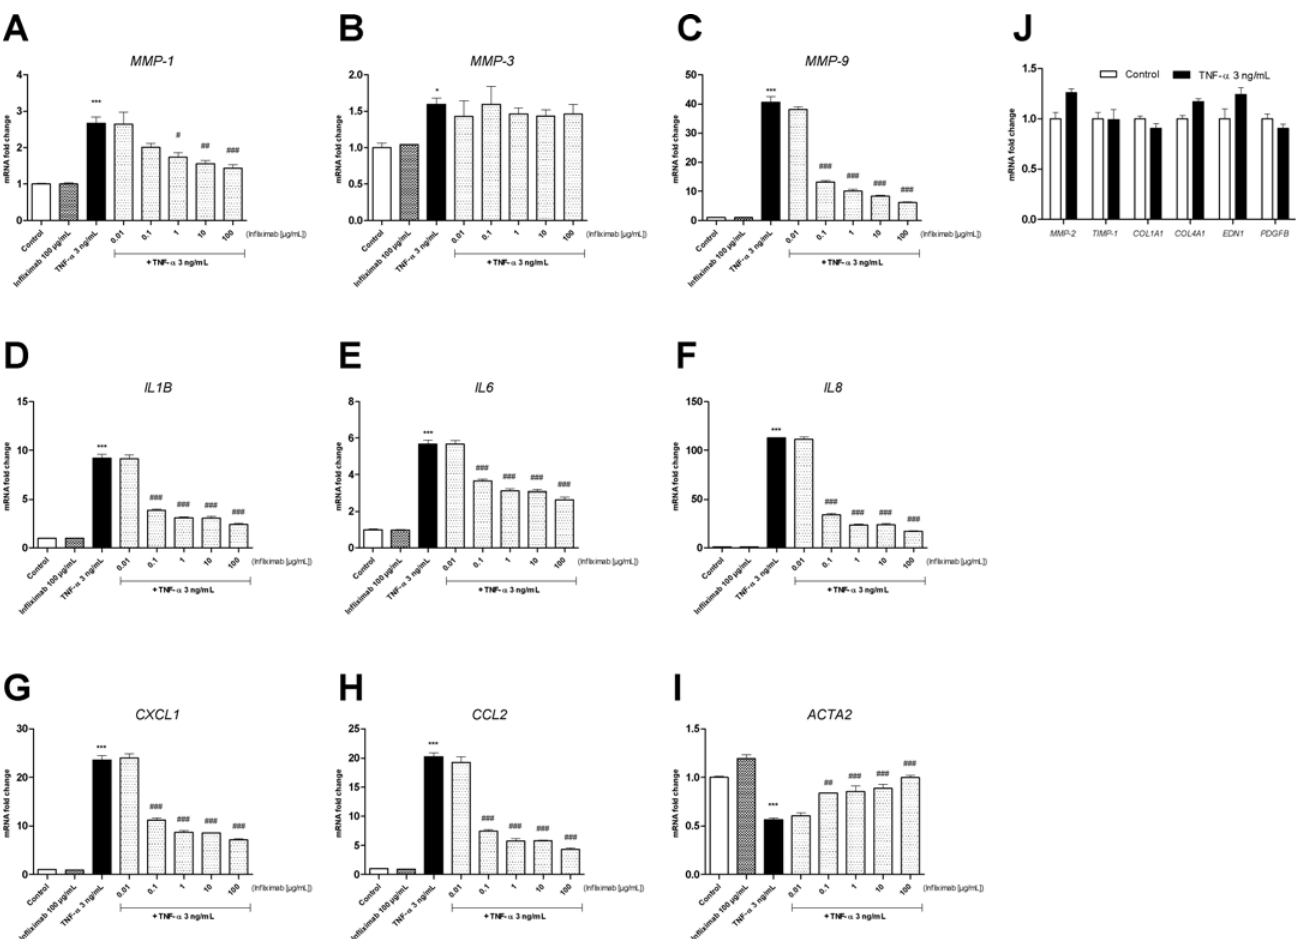
Fig 4. Effects of TNF- α treatment on the fibrolysis balance, fibrotic response and inflammatory response in LX-2 cells. The cells were pre-treated (or not) with the anti-TNF- α monoclonal antibody infliximab (at a dose ranging from 0.01 to 100 μ g/mL) and then treated with 3 ng/mL rhTNF- α for 24 hours. (A) mRNA expression of metalloproteinases (MMP-1, MMP-3 and MMP-9) myofibroblast differentiation factors (ACTA2/ α -smooth muscle actin), and proinflammatory cytokines (IL1B/interleukin-1 β , IL6/interleukin-6) and chemokines (CXCL8/interleukin-8, CXCL1/GRO α , CCL2/MCP1), as measured with real-time PCR and normalized against that of GAPDH after 24 hours of treatment. (B) mRNA expression of the tissue inhibitor of metalloproteinases (TIMP- 1), MMP-2, fibrogenesis factors (COL1A1/collagen I α 1, COL4A1/collagen IV α 1) and myofibroblast activation factors (EDN1/endothelin-1, PDGFB/platelet- derived growth factor-BB), as measured with real-time PCR and normalized against that of GAPDH after 24 hours of treatment. Results are expressed as the mean ± SEM of three independent experiments. * p < 0.05, *** p < 0.001, relative to a control. # p < 0.05, ## p < 0.01, ### p < 0.001, relative to TNF- α .